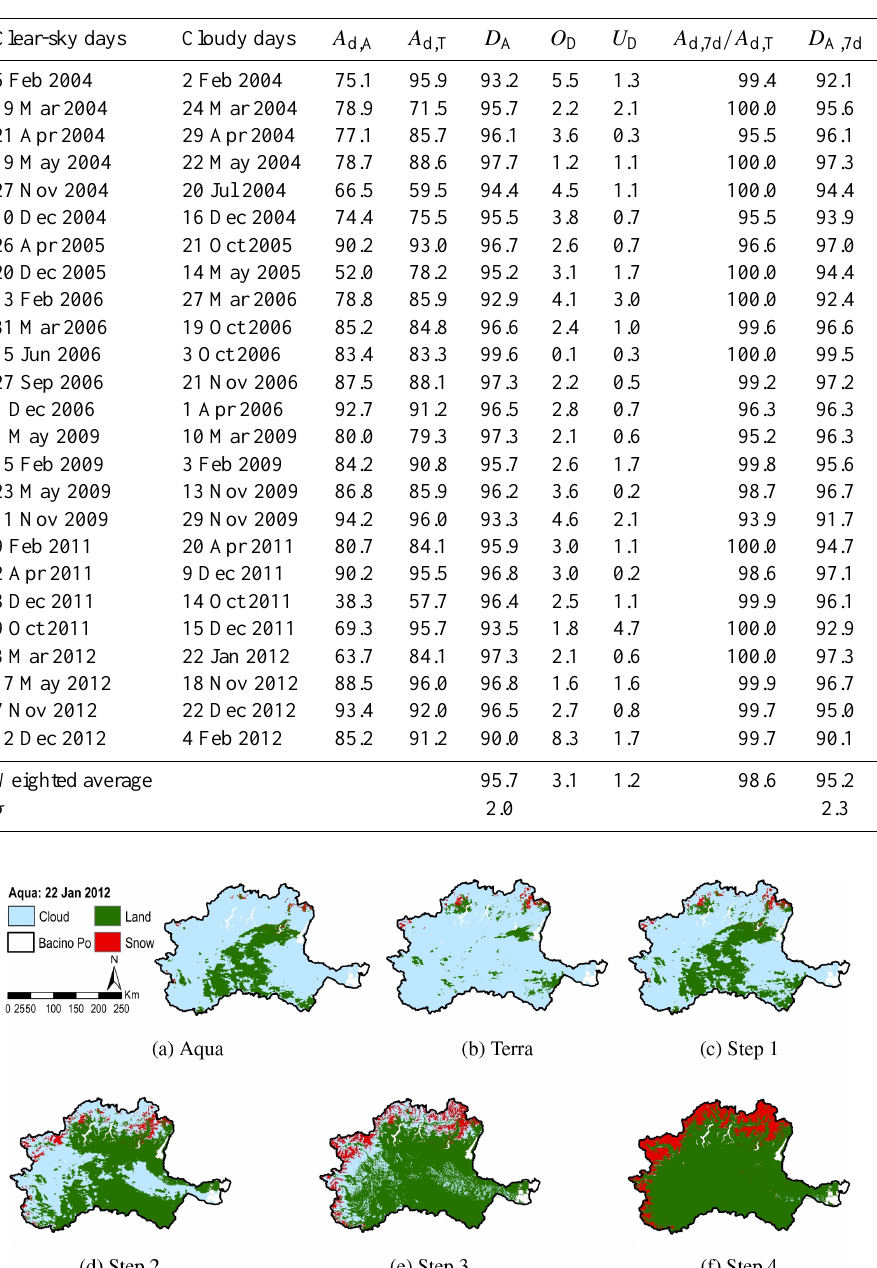
Table 7. Overall accuracy of the cloud removal methodology tested on several days and comparison with a basic 7-day backward temporal filter. Values in [%].